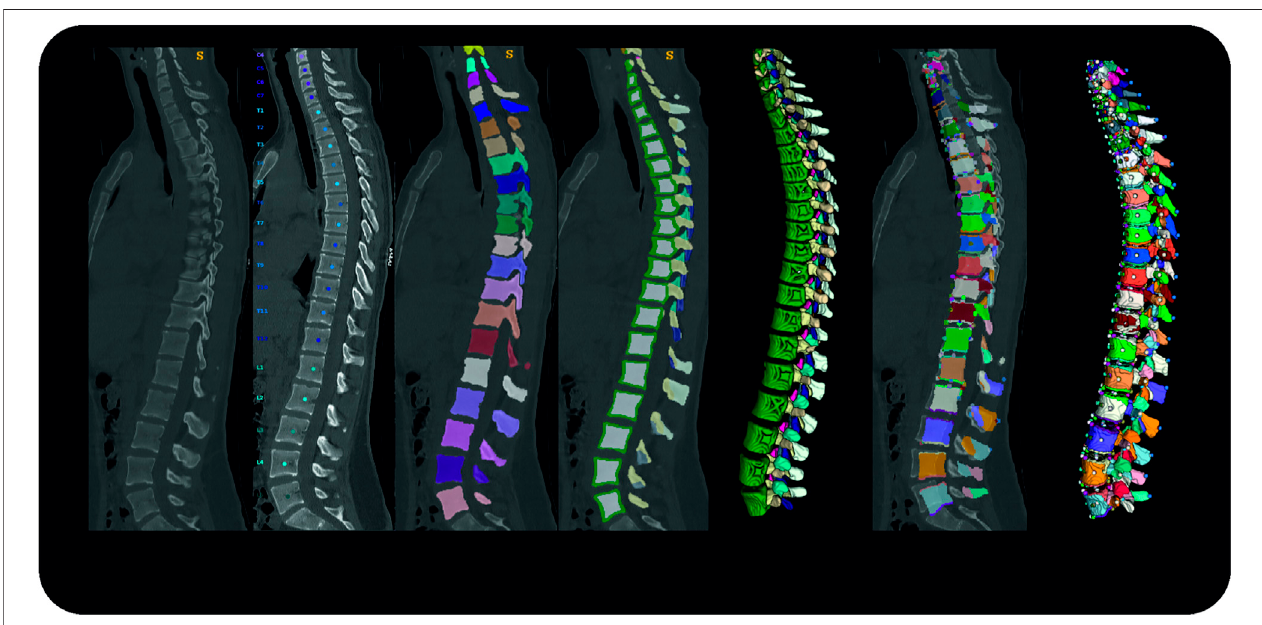
FIGURE 1 | Pipeline Overview from left to right; original data, vertebrae identi fi cation; vertebrae segmentation; subregion segmentation (cross-section and 3D rendering); re-alignment in craniocaudal direction and calculation of points of interest; 3D rendering of the fi nal